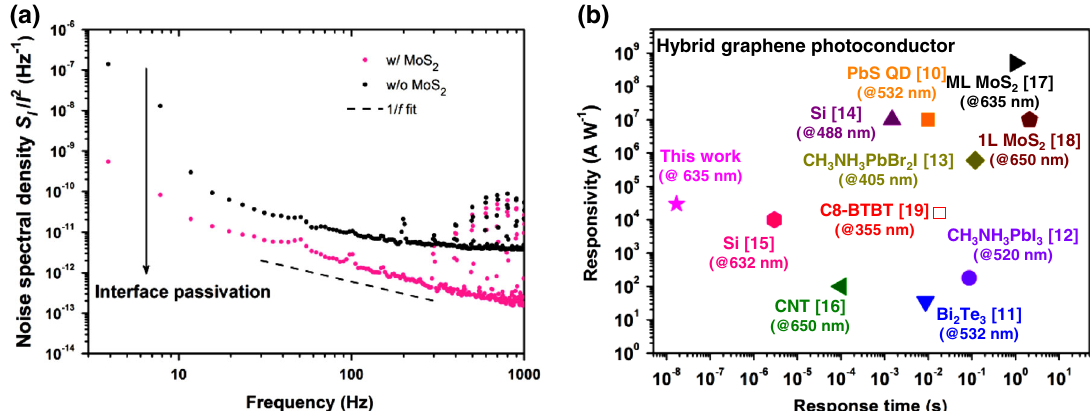
Fig. 5 a Normalized noise spectral density ( S I / I 2 ) as a function of frequency ( f ) for the hybrid graphene photoconductor with and without monolayer MoS 2 passivation. Dashed line gives the guide to eyes for 1/ f noise. Sharp peaks at 50 Hz and its harmonics are induced by power source. b Comparison between response time (rising time) and responsivity of our device and those of typical reported hybrid